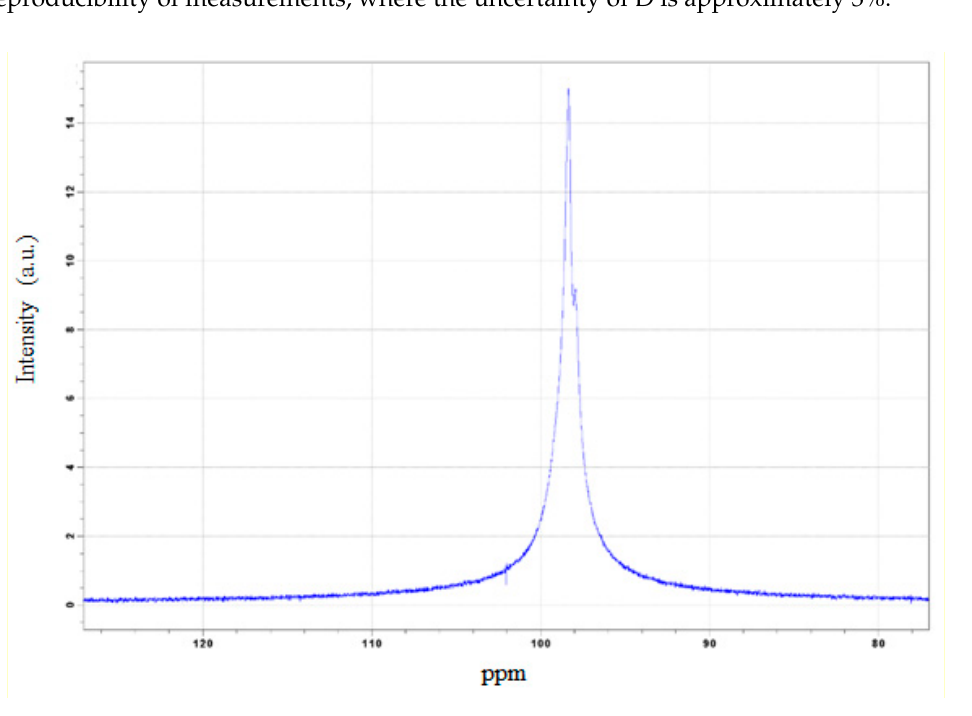
Figure 2. FT-NMR spin echo spectrum for the virgin bitumen.